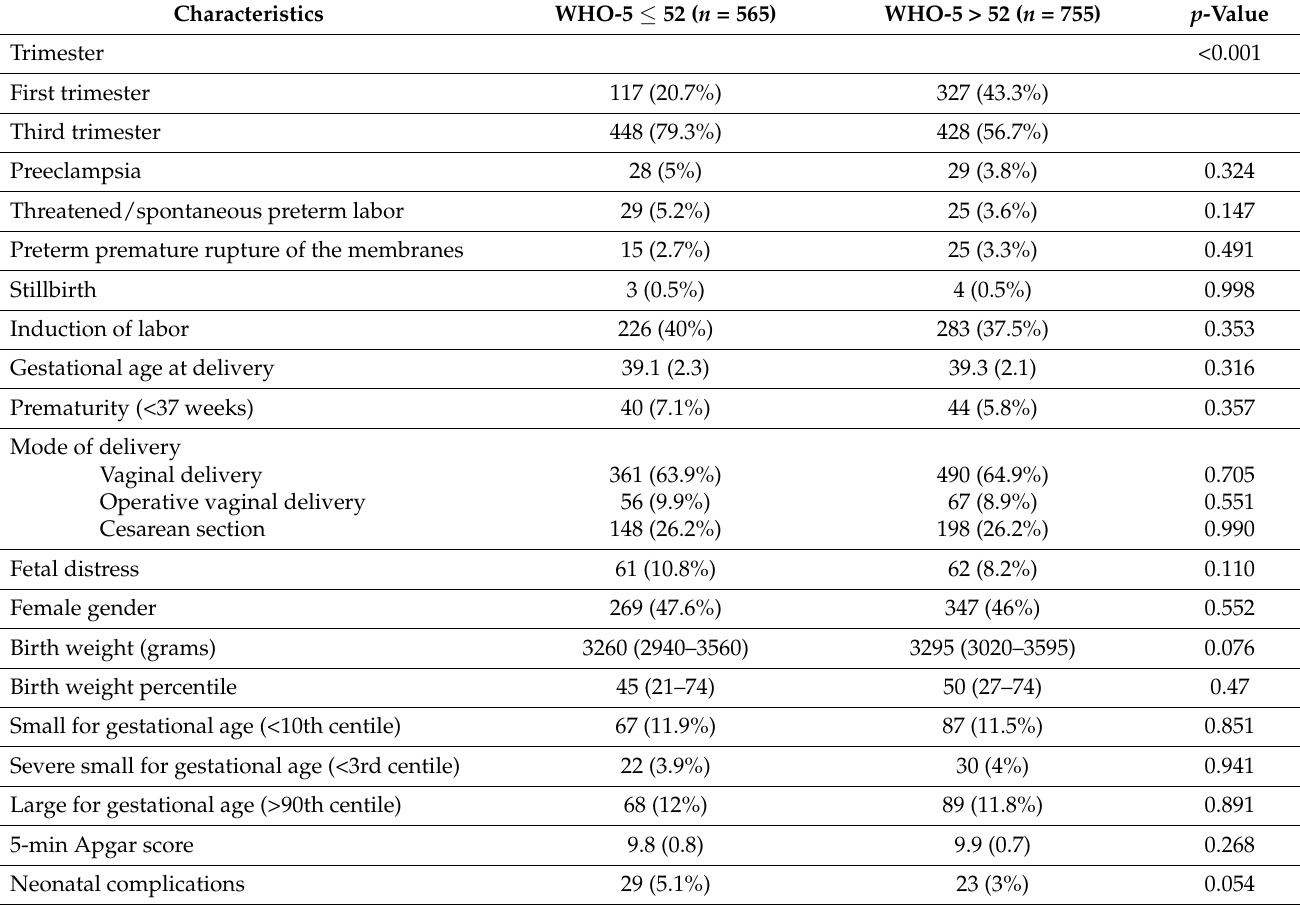
Table 4. Pregnancy and neonatal outcomes for the pandemic cohort based on WHO-5 well-being. Characteristics